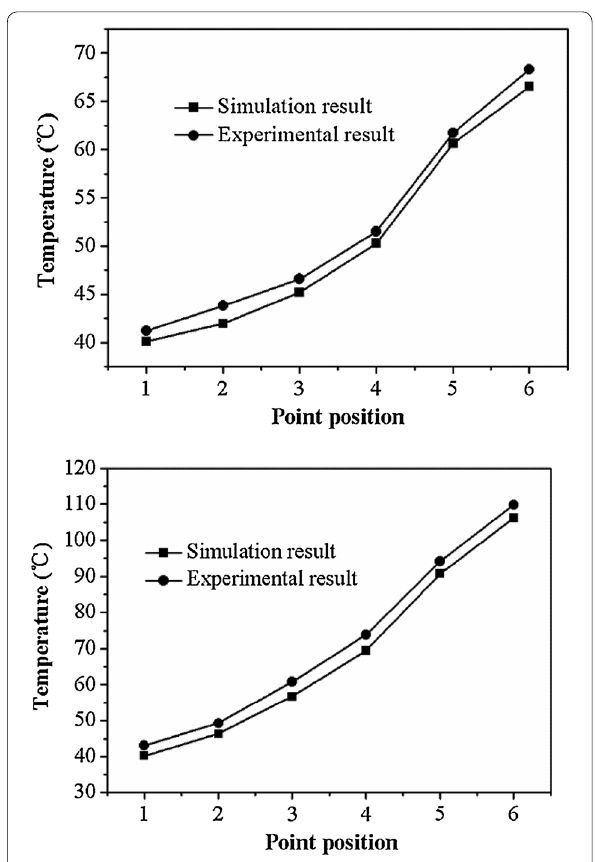
Figure 14 Comparison between the experiment value and temperature value at the measuring